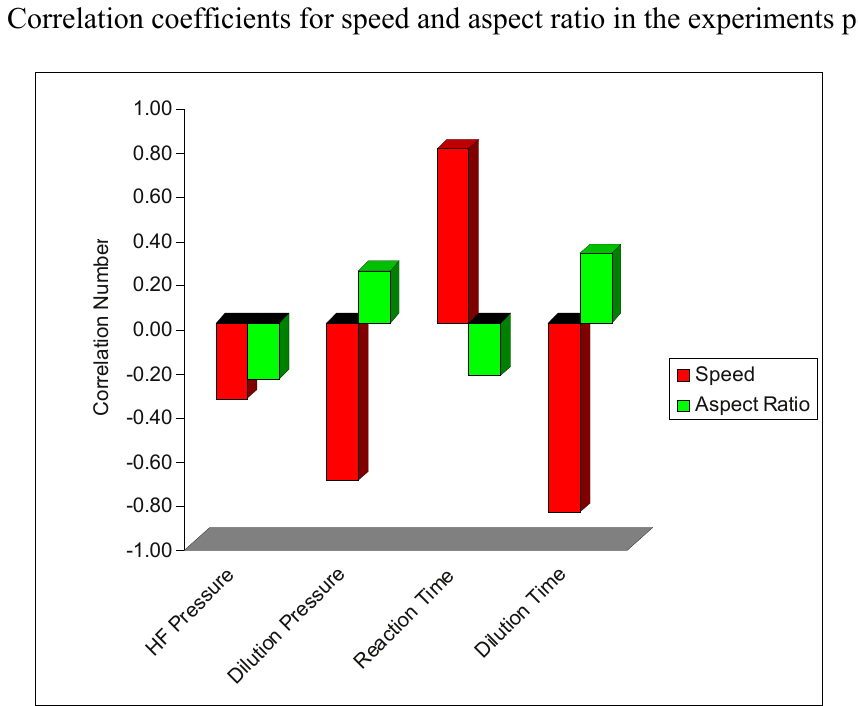
Figure 6. Correlation coefficients for speed and aspect ratio in the experiments